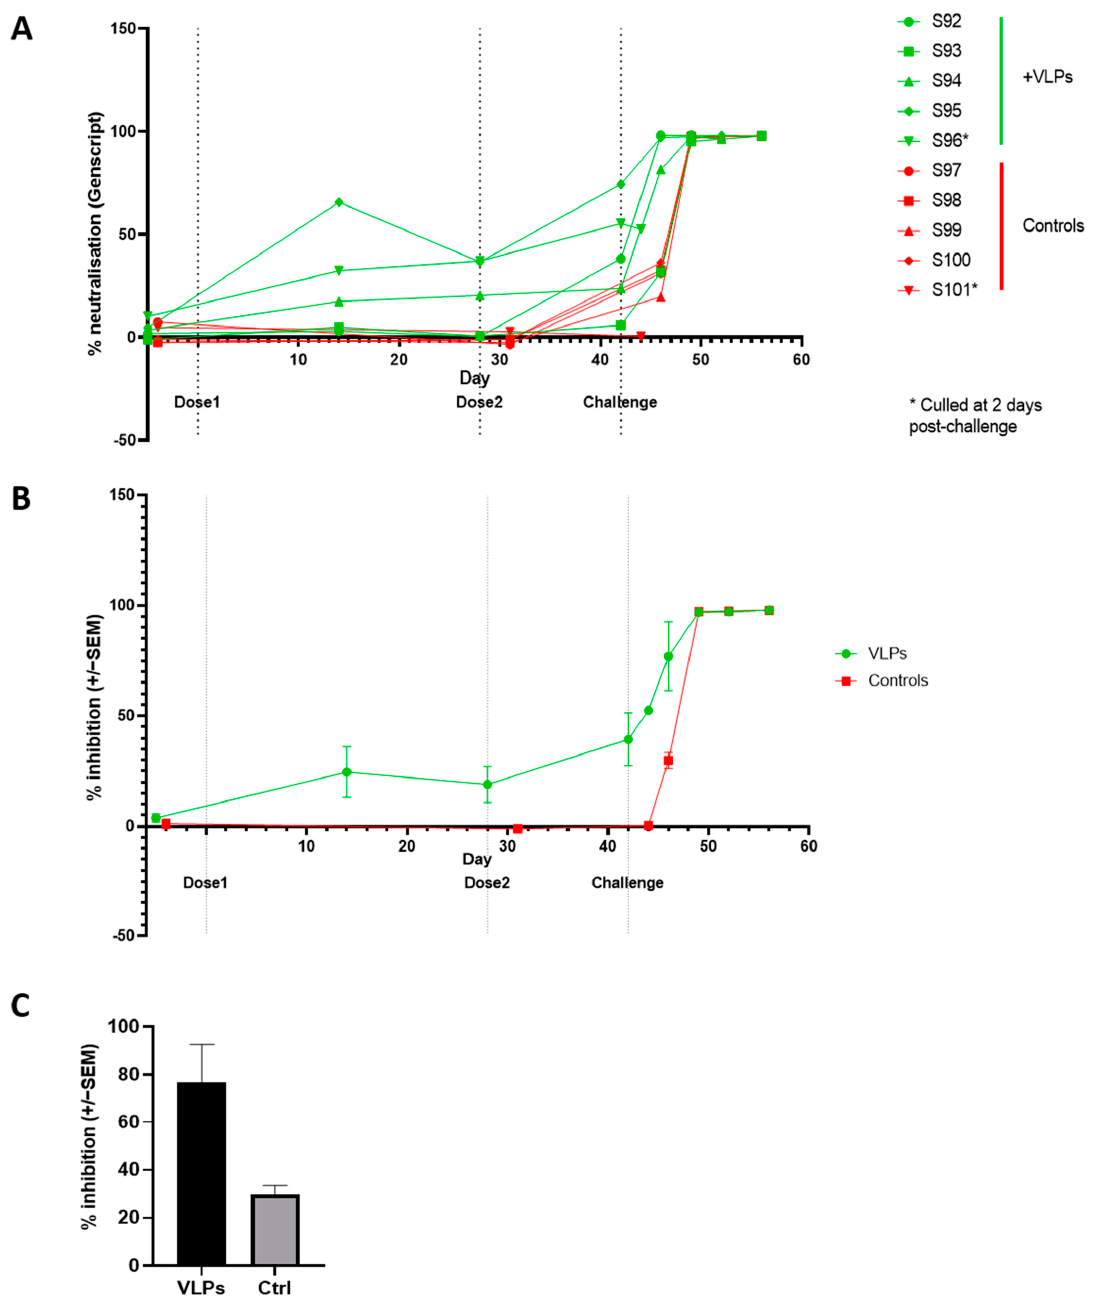
Figure 6. Neutralizing antibody responses to SARS-CoV-2 and vaccination. ( A ) Individual antibody titres throughout the experiment as determined by the cPass total neutralizing antibody ELISA and ( B ) mean of group +/ − SEM. ( C ) At day 4 post challenge a single animal (S96) from the VLP treated group had a higher level of RBD blocking antibody than a control animal (S101). *—animals culled